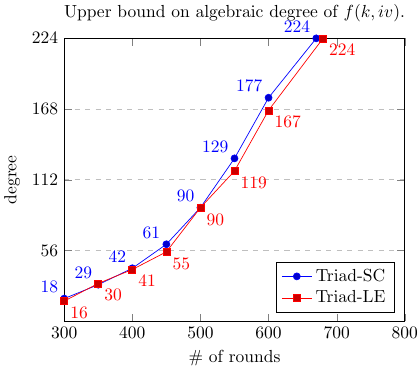
Figure 18: Increase in algebraic degree with respect to the number of initialization